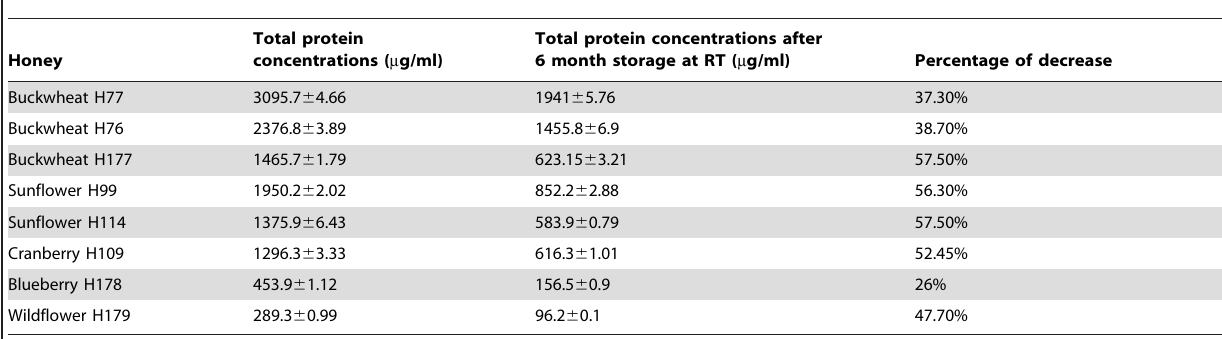
Table 2. Changes in the protein concentration in different honeys during storage (n =3–6).